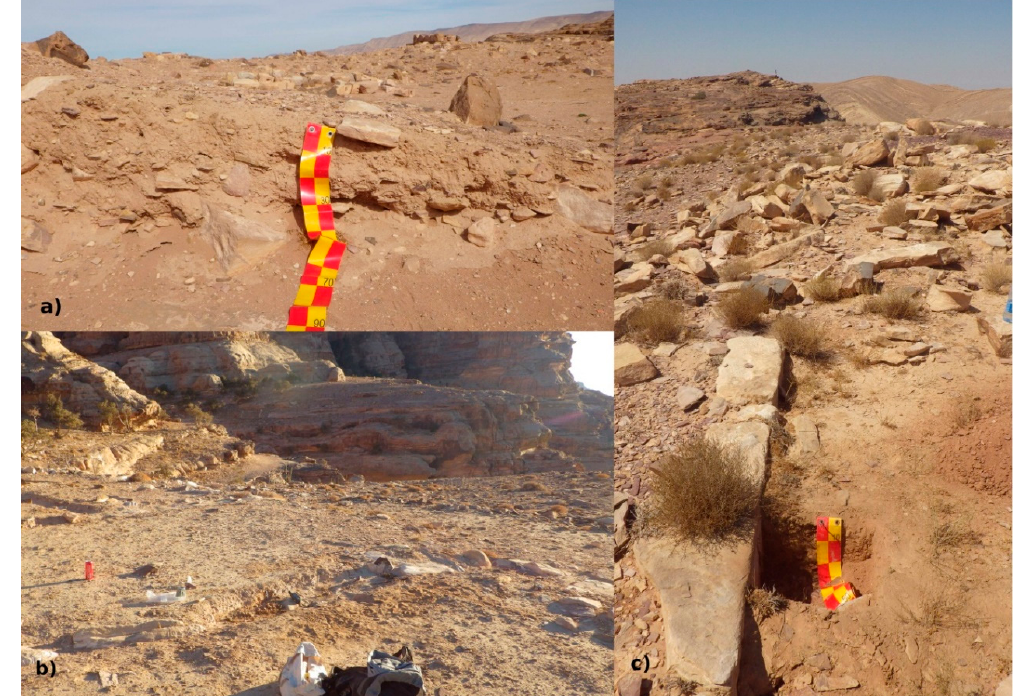
Figure 4. Profiles sampled at Horvat Haluqim in the Negev. ( a ) The hilltop ruin near the western wadi, ( b ) the ruin on the loess spur projecting into the central wadi, and ( c ) the paleosol of the colluvial-aeolian loessial apron in Nahal HaRo'a. The tape measure is in cm. For a detailed description of the profiles, see Appendix A.